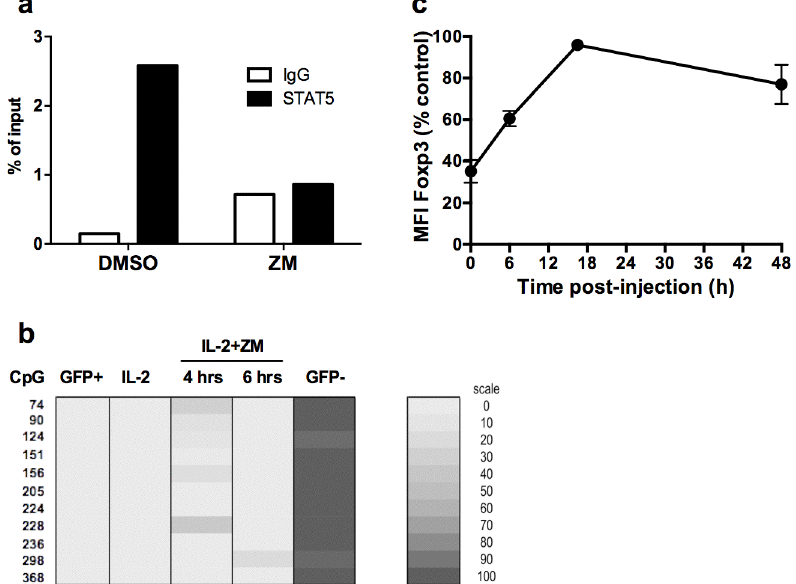
Fig 4. Loss of Foxp3 is not due to remethylation of the CNS2 and is reversible. (a) STAT5 binding on a putative binding site in the TSDR enhancer of the foxp3 gene was assessed by chromatin immunoprecipitation with control IgG or anti-STAT-5 antibodies. Quantification of binding was performed as described in Methods section. These data are from one representative experiment out of two. ( b ) Methylation status of the Foxp3 TSDR was determined by bisulphite sequencing. Expanded CD4 + GFP + T cells were treated with IL-2 and ZM (IL-2+ZM) for 4 (4 hrs) or 6 (6 hrs) hours. Freshly purified CD4 + GFP + (GFP + ), CD4 + GFP - (GFP - ), or untreated expanded cells (IL-2) were used as controls. These data are representative of two independent experiments. Each line indicate the position in the Foxp3 locus (CpG), according to Floess et al. [11]. A shaded scale of grey illustrates the frequency of each methylated CpG. (C) For in vivo analysis, expanded CD4 + GFP + cells treated or not with AG for two hours were injected into congenic C57BL/ 6 mice. Animals were euthanized at the indicated times after transfer. The MFI of Foxp3 was normalized to vehicle-treated control